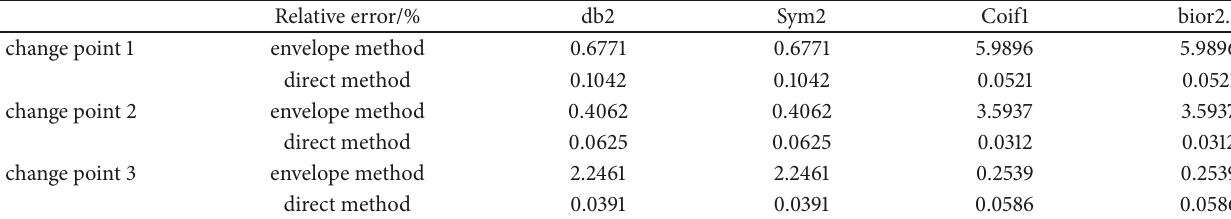
Table 5: Comparison of relative error of the envelope method and the direct